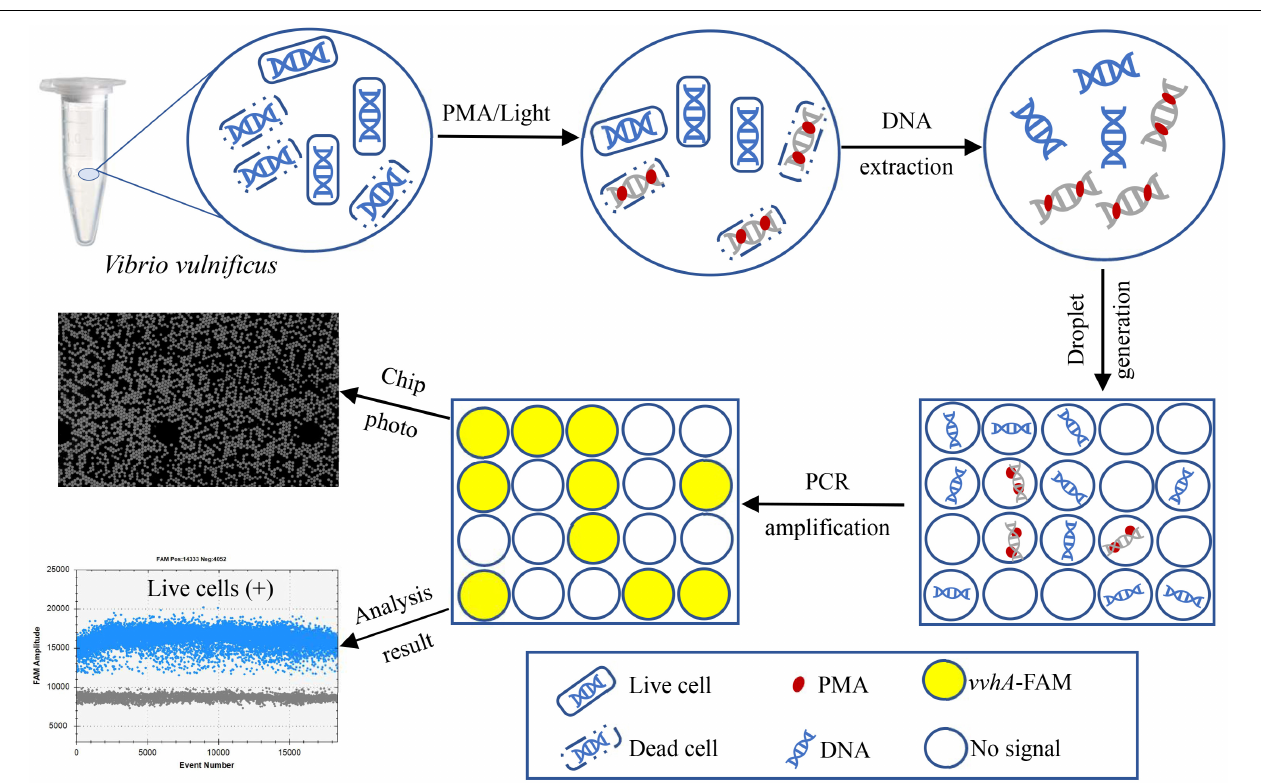
FIGURE 1 | Technical route of PMA-ddPCR for the accurate detection of live cells of V. vulnificus by targeting the vvhA